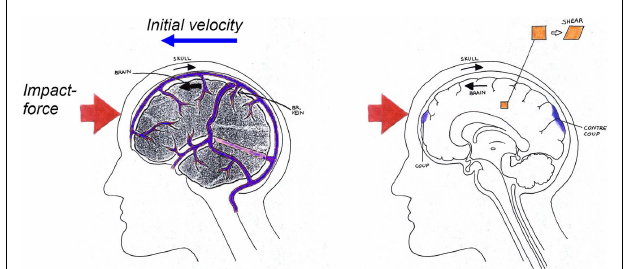
FIGURE 2 | Schematical description of the biomechanics of subdural hematoma (left), concussions, contusions, intra-cerebral hematomas, and diffuse axonal injuries (right) when impacted against a surface as illustrated in Figure 1